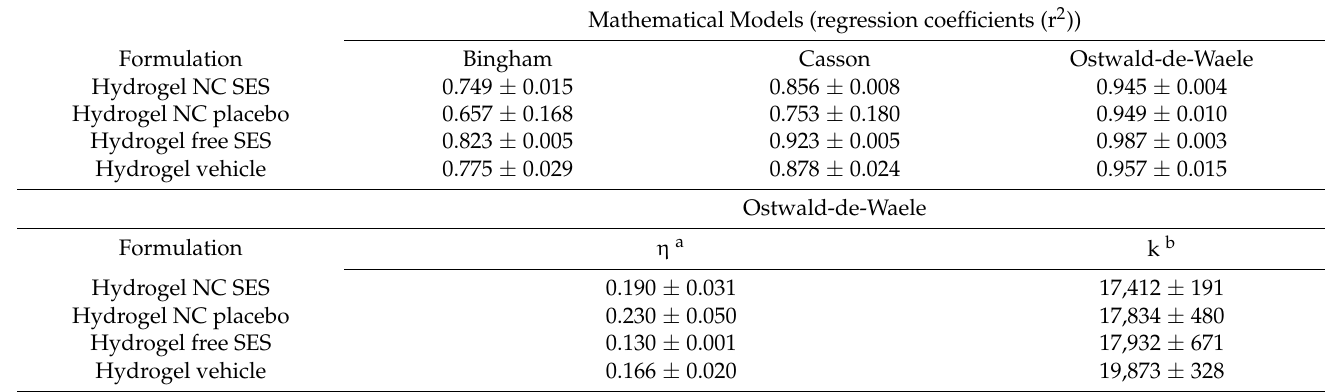
Table 3. Regression coefficients (r 2 ) and mathematical equations to models of Bingham, Casson, and Ostwald-de-Waele.